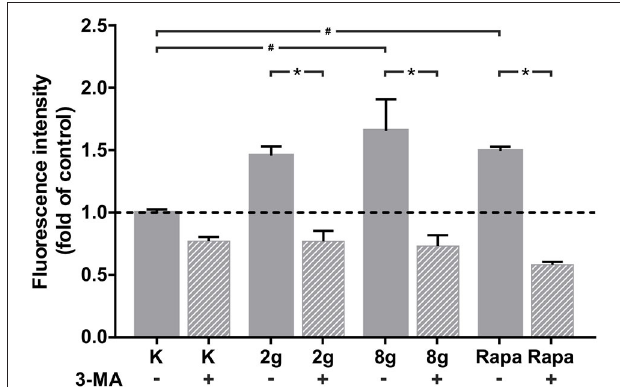
FIGURE 2 | Autophagosome accumulation, indicated by fluorescence, after 16 h of treatment with 2 g/cm 2 , 8 g/cm 2 or Rapamycin (Rapa; 50 nM) with or without autophagy inhibitor 3-MA. Untreated cells served as control. Unstained cells served as negative control (not shown). Fluorescence intensity is shown as fold of control. Mean ± SEM ( n = 8 replicates); # significant ( p < 0.05) difference between groups as determined by Dunnett’s T -test. ∗ significant ( p < 0.05) difference between two groups (uninhibited and inhibited) as determined by the